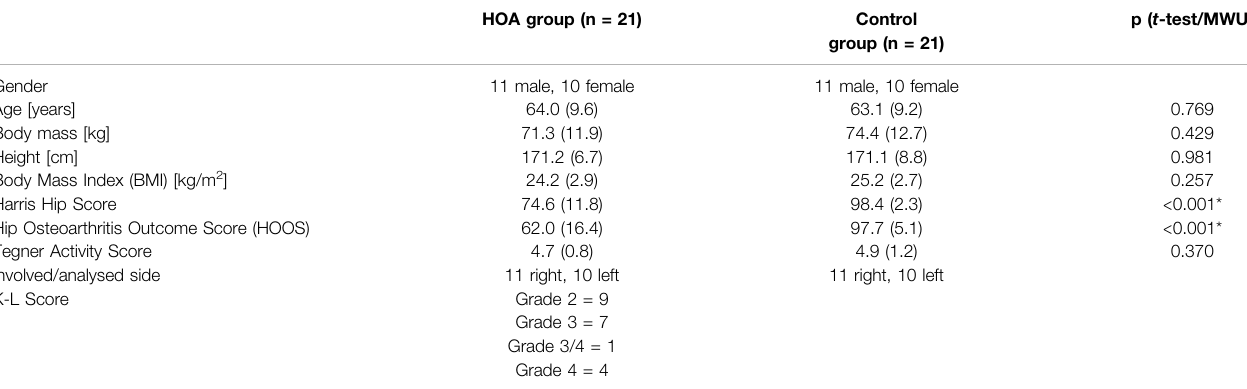
TABLE 2 | Mean values and standard deviations of the subject characteristics of the HOA and control groups with respective p -values as revealed by independent sample t-tests/Mann-Whitney-U tests (MWU). Level of signi fi cance ≤